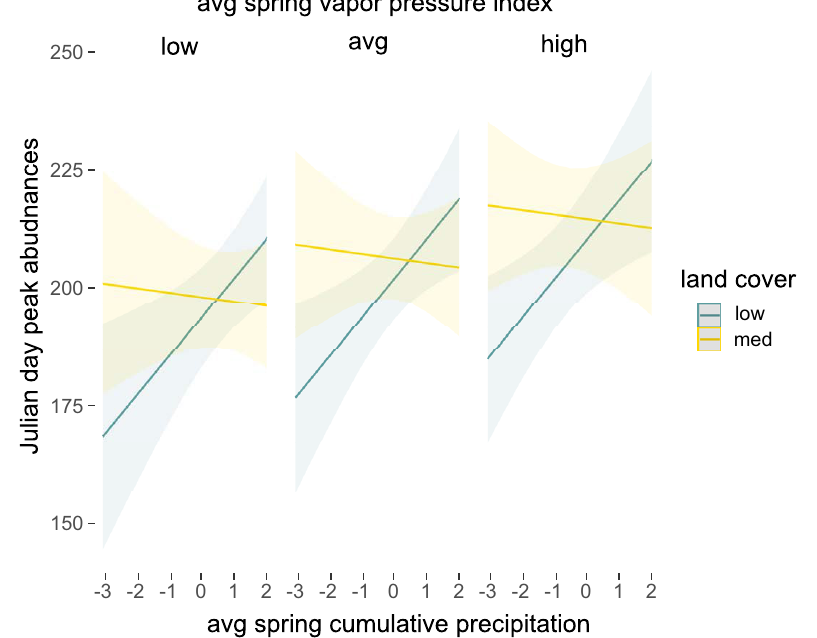
Figure 4. Average spring cumulative precipitation leads to much later peak abundances in areas classified as low development, but slightly earlier peaks in medium developed areas. Drier conditions (higher vapor pressure deficit) lead to later peak abundances independent of land cover type. Plots were generated using the ‘plot_ model’ function in the sjPlot package and functions in ggplot2 package in